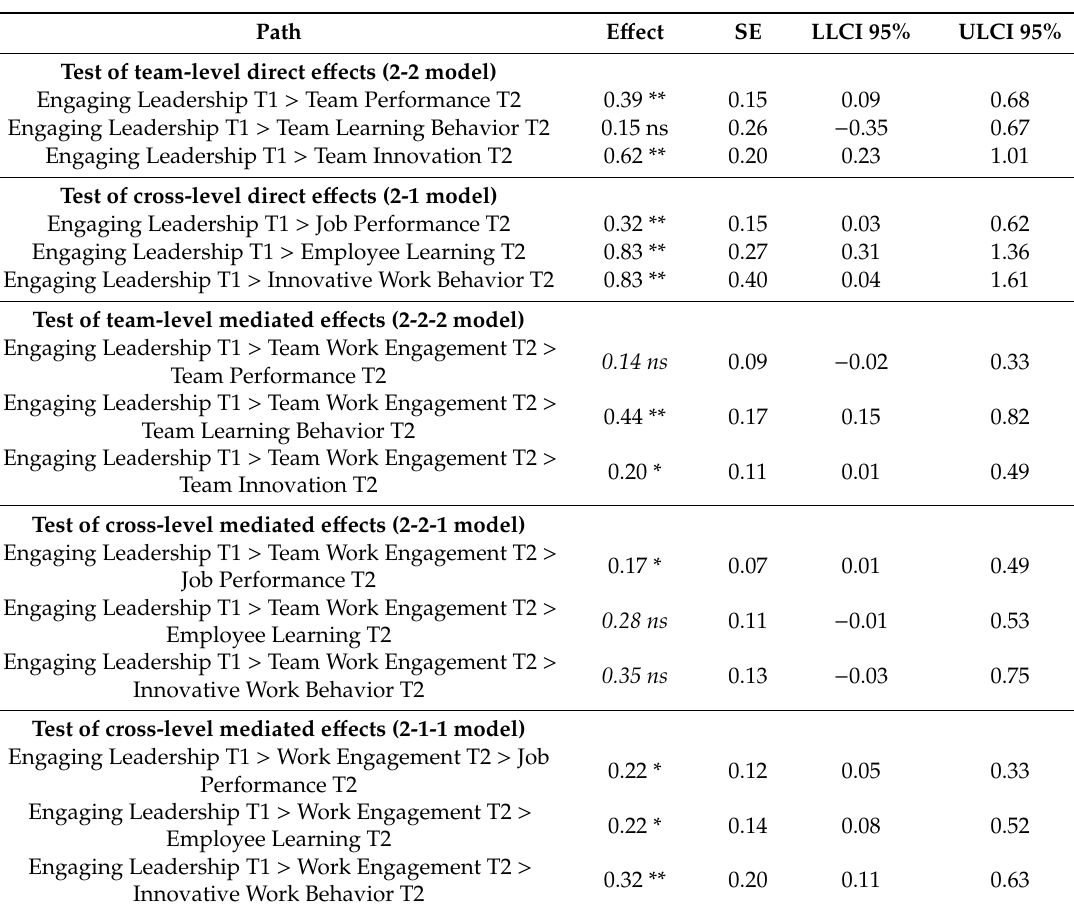
Table 6. The Summary of Team-Level and Cross-Level Direct and Mediated E ff ects of Engaging Leadership at the Team Level on Team-Level and Individual-Level Outcomes (Individual Level, N = 224, Team Level, N =